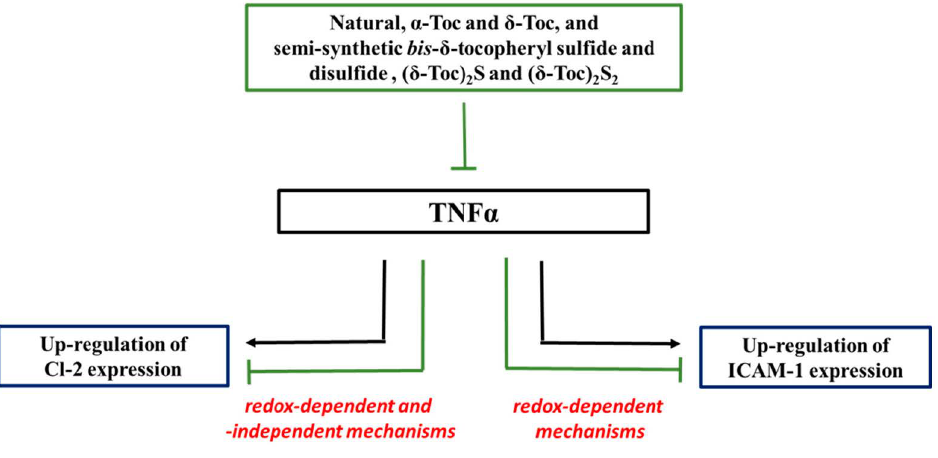
Figure 6. Schematic diagram illustrating the role of natural, α -Toc , δ -Toc , and semi-synthetic ( δ -Toc) 2 S and ( δ -Toc) 2 S 2 on TNF α -induced ICAM-1 and Cl-2 expression in HT29 cells. TNF α up-regulates ICAM-1 expression by redox-regulated mechanisms, and Cl-2 expression by redox- and non-redox-regulated mechanisms. Natural tocopherols and semi-synthetic δ -tocopheryl sul- fide and disulfide inhibit both these mechanisms and prevent the up-regulation of ICAM-1 and Cl-2